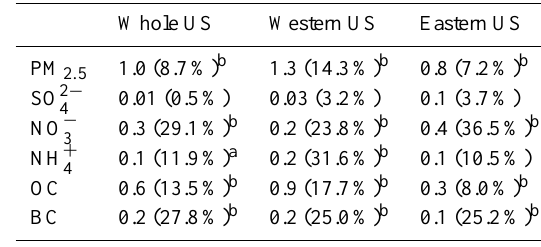
Table 1. The absolute (µgm − 3 ) and relative (%) differences in observed aerosol concentrations between the PNA + and PNA − months (PNA + minus PNA − ). The observed concentrations are av- eraged over all the sites in the whole of US, in the western US, or in the eastern US. See Fig. 1 for locations of the sites. The measure- ments are from the EPA-AQS